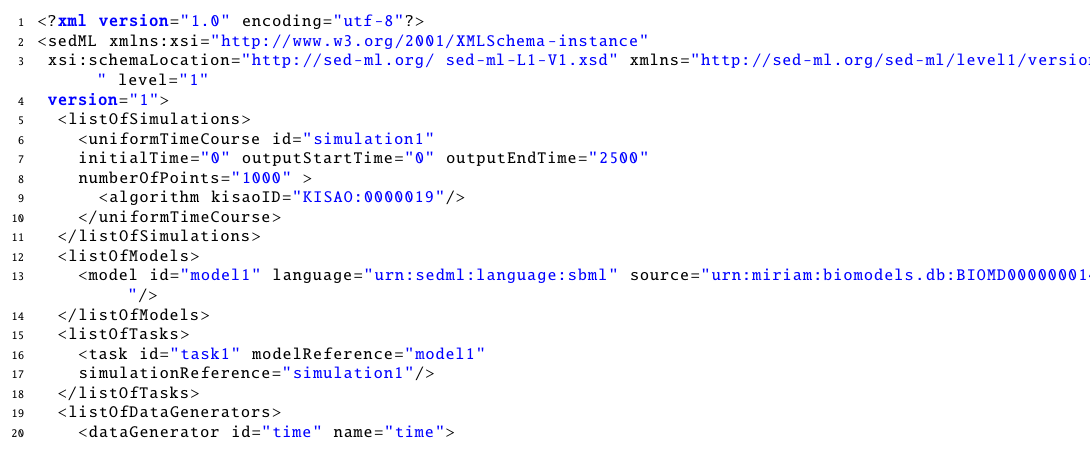
The SED-ML description of the simulation experiment is given in Listing